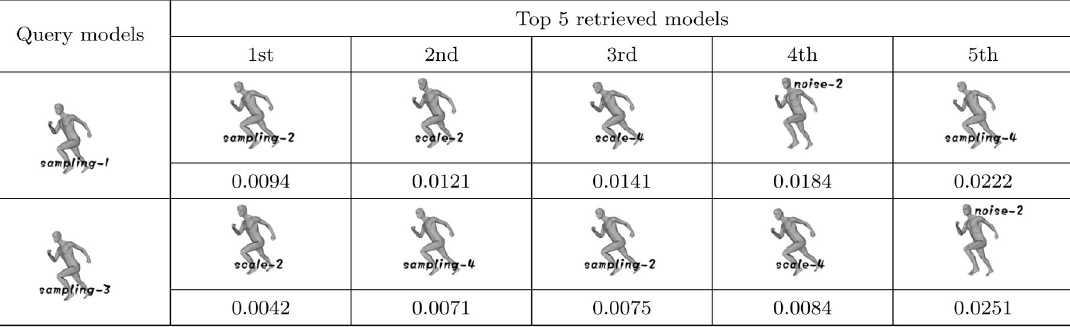
Table 3. The query results of sampling invariance testing.